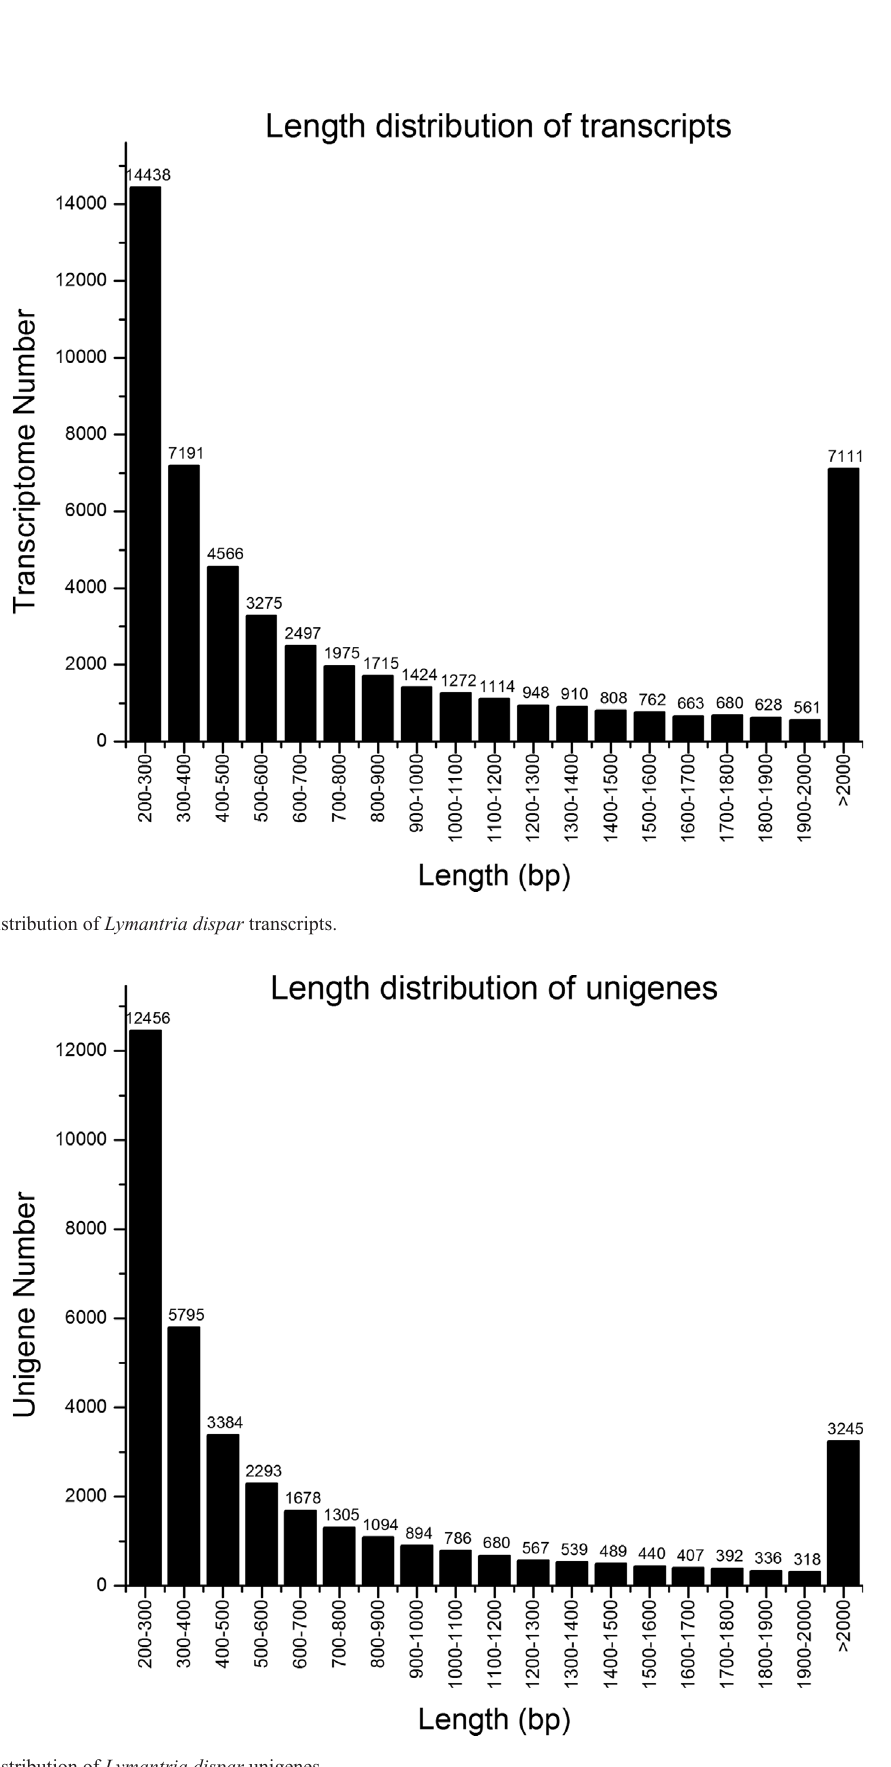
Figure 2 - Length distribution of Lymantria dispar